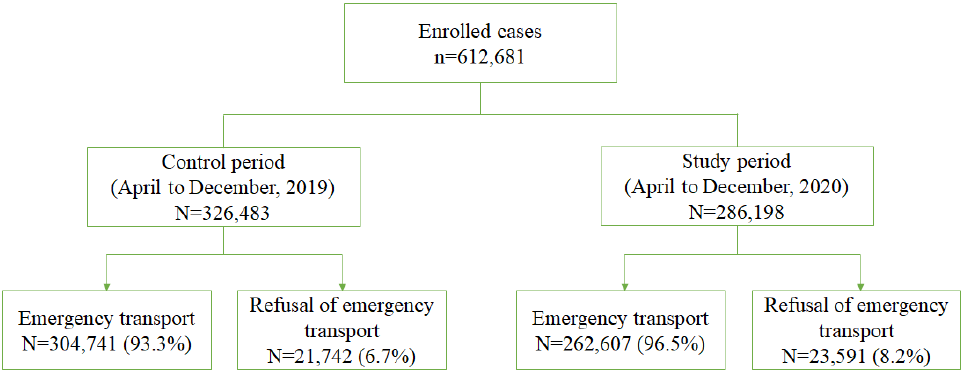
Figure 1. Study flow diagram.